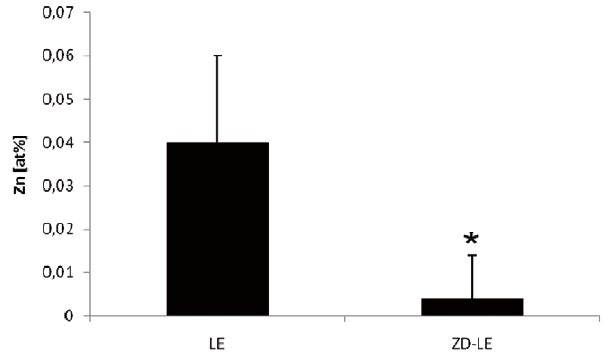
Figure 1. Zinc mole fraction (in at%) of melanosomes in the RPE of control LE and ZD-LE animals as determined by quantitative EDX spectroscopy in the TEM. In the ZD-LE group (0.004 6 0.01 at% zinc) which is below the detection limit of 0.02 at%, the zinc mole fractions were significantly lower compared to the control group (0.04 6 0.02 at% zinc) (p=0.02, t test).